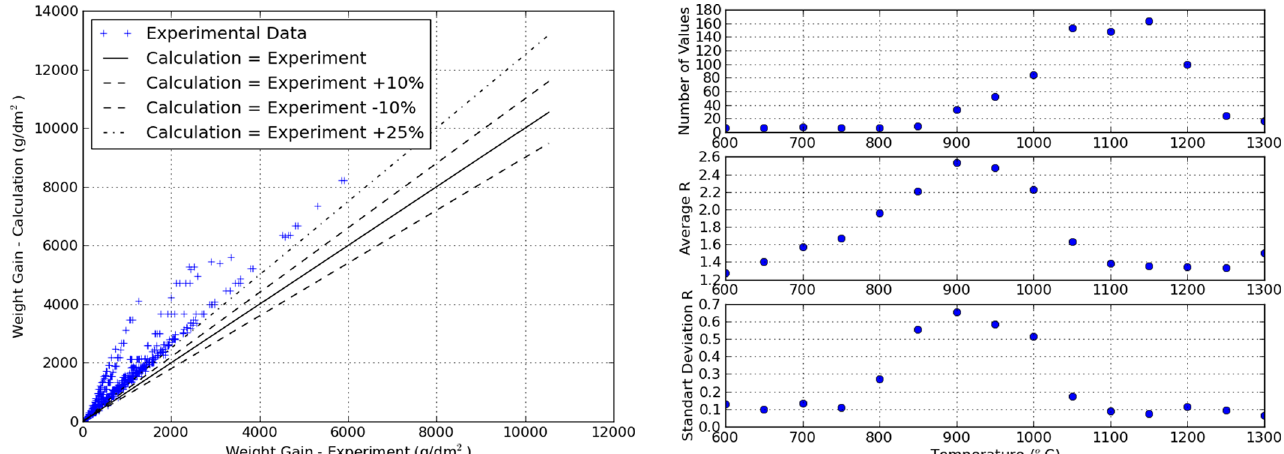
Fig. 8. Comparison of experimental and Solyany correlation data. Weight gain for all data (left) and R -parameter for each evaluated temperatures (right).